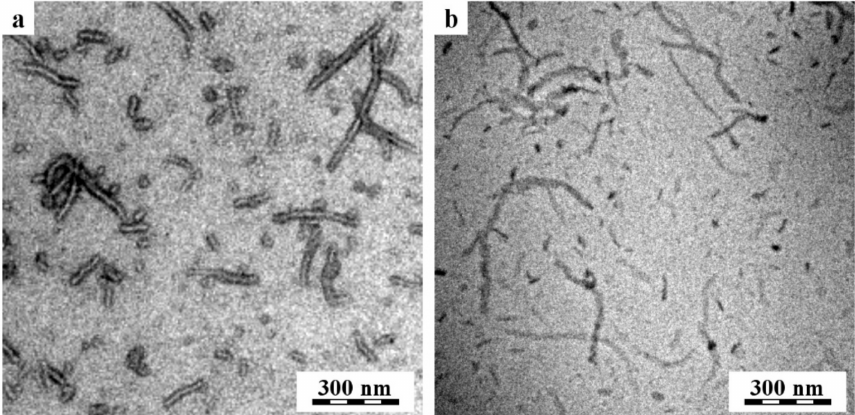
Figure 1. TEM microscopy of curcumin-loaded (EtOx) 88 - grad -(HexOPhOx) 12 NPs: ( a ) TEM after negative staining and ( b ) cryogenic TEM (cryo-TEM). Both independent sample preparation tech- niques confirmed the worm-shaped morphology of the nanoparticles. The feeding concentrations of polymer and curcumin used to prepare the NPs were 4 mg/mL and 0.036 mg/mL,